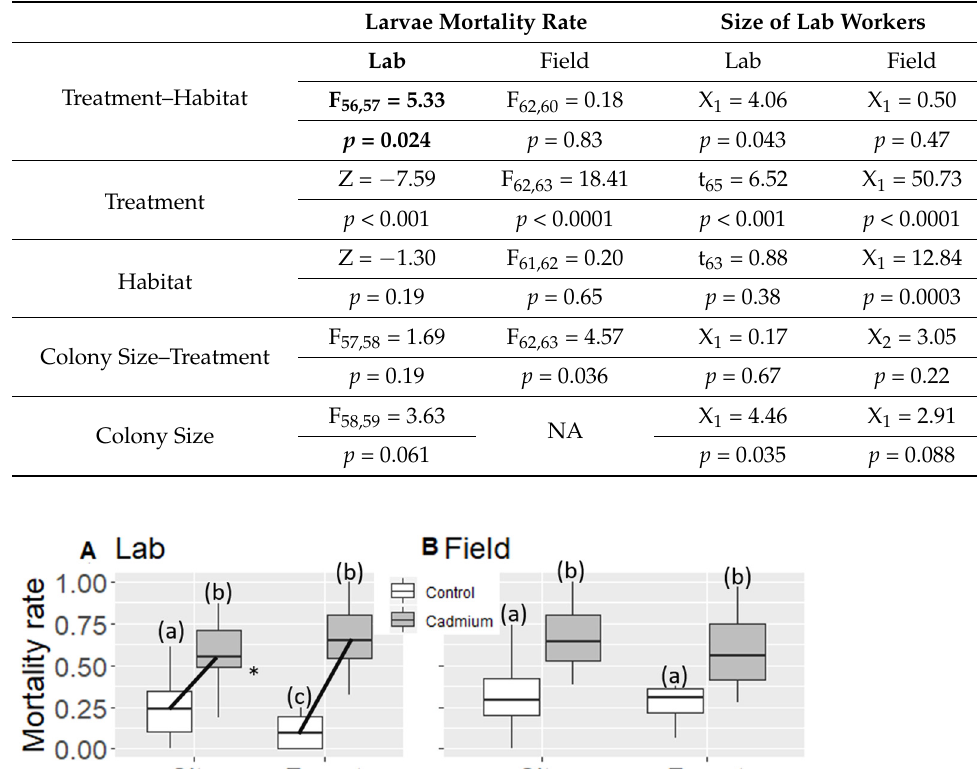
Table 2. Summary of statistical analyses performed by splitting dataset according to hibernation conditions on larvae mortality rate and size of lab workers. For each model, we tested the effect of habitat (city and forest), treatment (control or cadmium), and colony size. Left side of the column: laboratory hibernation condition (Lab), right side of the column: field hibernation condition. Bold number indicates significant p -value.